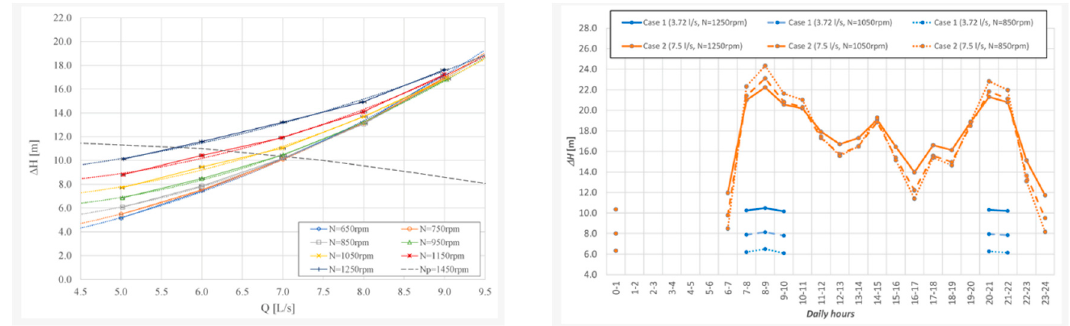
Figure 12. Measured PAT curves and daily distribution of the head drop for variable impeller speed [20].